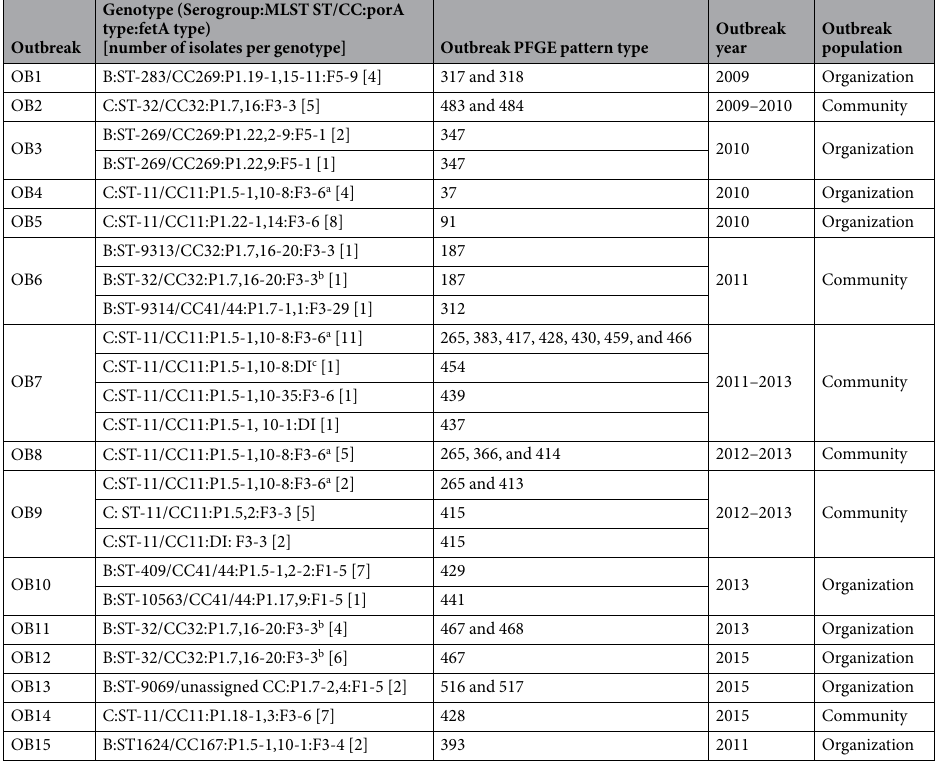
Table 1. Characteristics of 2009–2015 outbreak isolates. a Genotype observed in multiple NmC outbreaks (OB4, OB7, OB8, and OB9). b Genotype observed in multiple NmB outbreaks (OB6, OB11, and OB12). c DI indicates deletion within